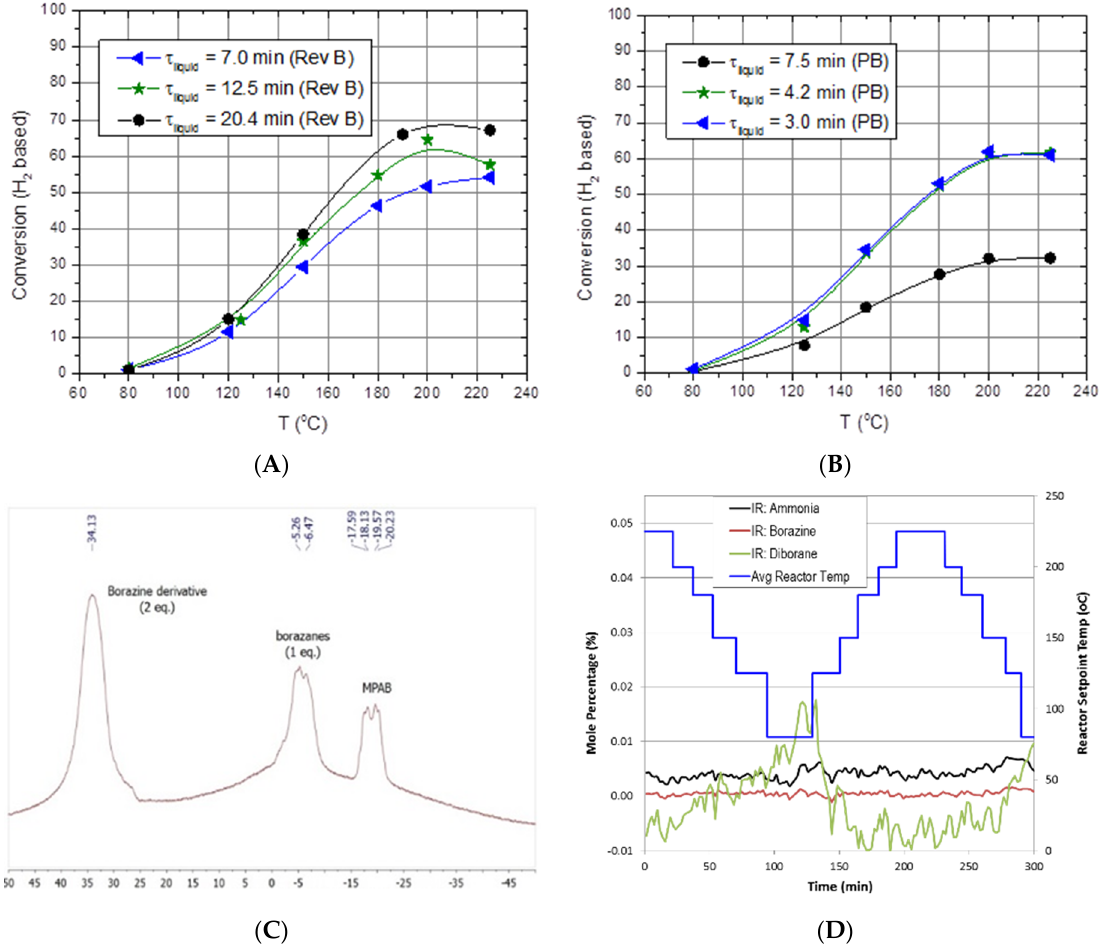
Figure 10. Representative results of methoxypropyl amine borane (MPAB). ( A ) Conversion as a function of reactor temperature and space–time for helicial reactor, ( B ) conversion as a function of reactor temperature and space–time for SiC packed bed (PB) reactor, ( C ) NMR analysis of liquid-phase products, ( D ) in situ gas-phase IR analysis of impurities generated from methoxypropyl amine borane (MPAB) dehydrogenation.